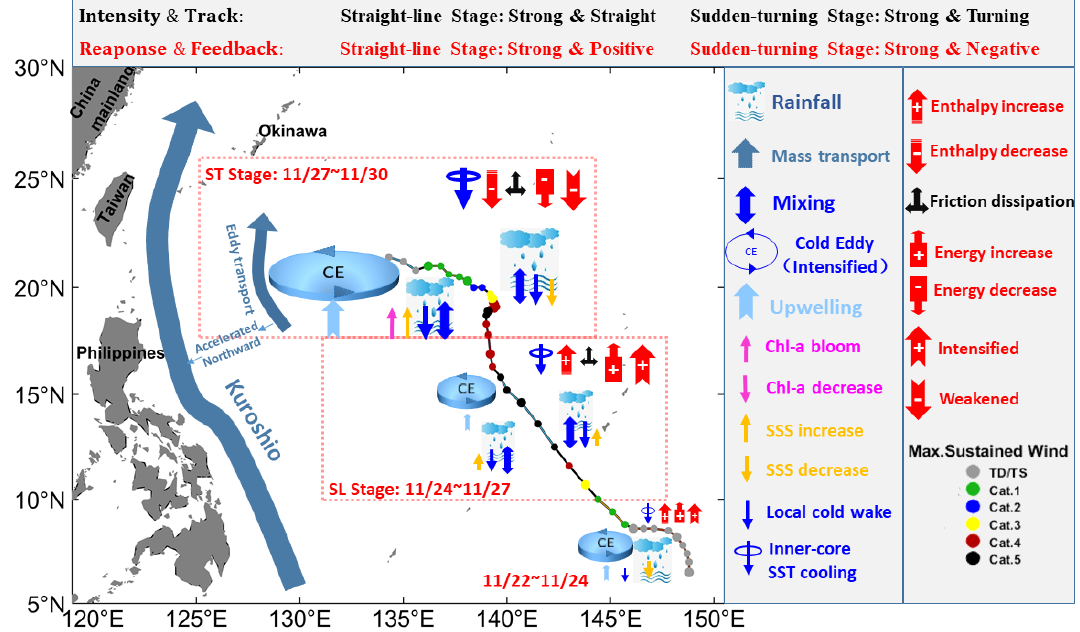
Figure 11. Schematic illustration of the interaction between super typhoon Nida and the ocean environment.